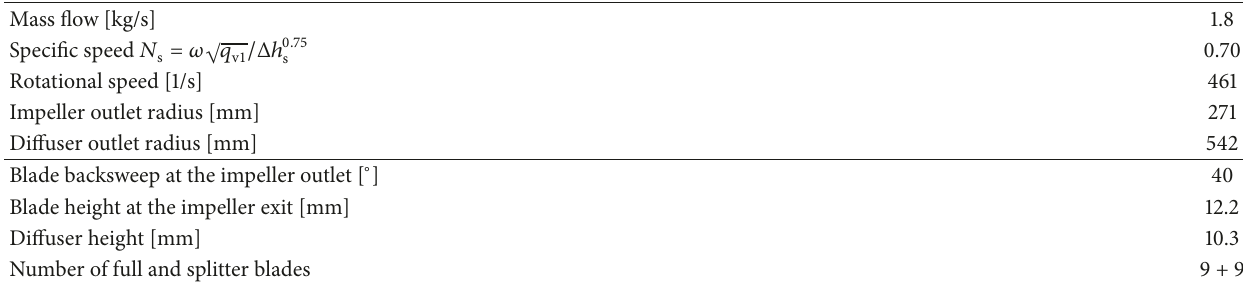
Table 1: The main design parameters.